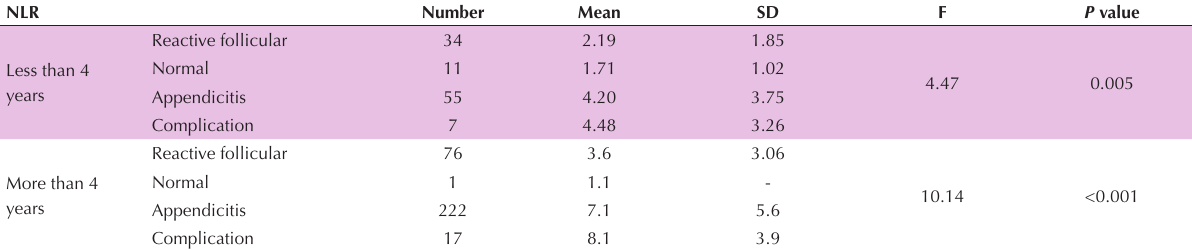
Table 2. Comparison of mean NLR in normal, appendicitis, complication and reactive follicular groups in different age groups NLR